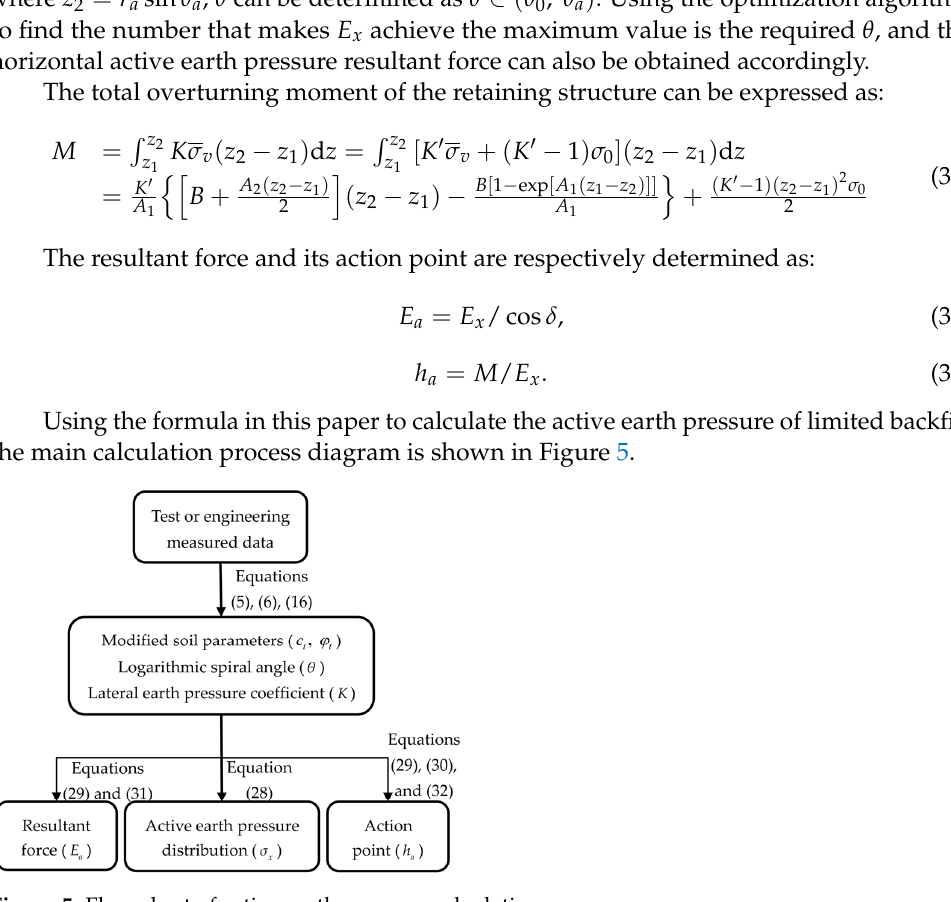
Figure 5. Flow chart of active earth pressure calculation.